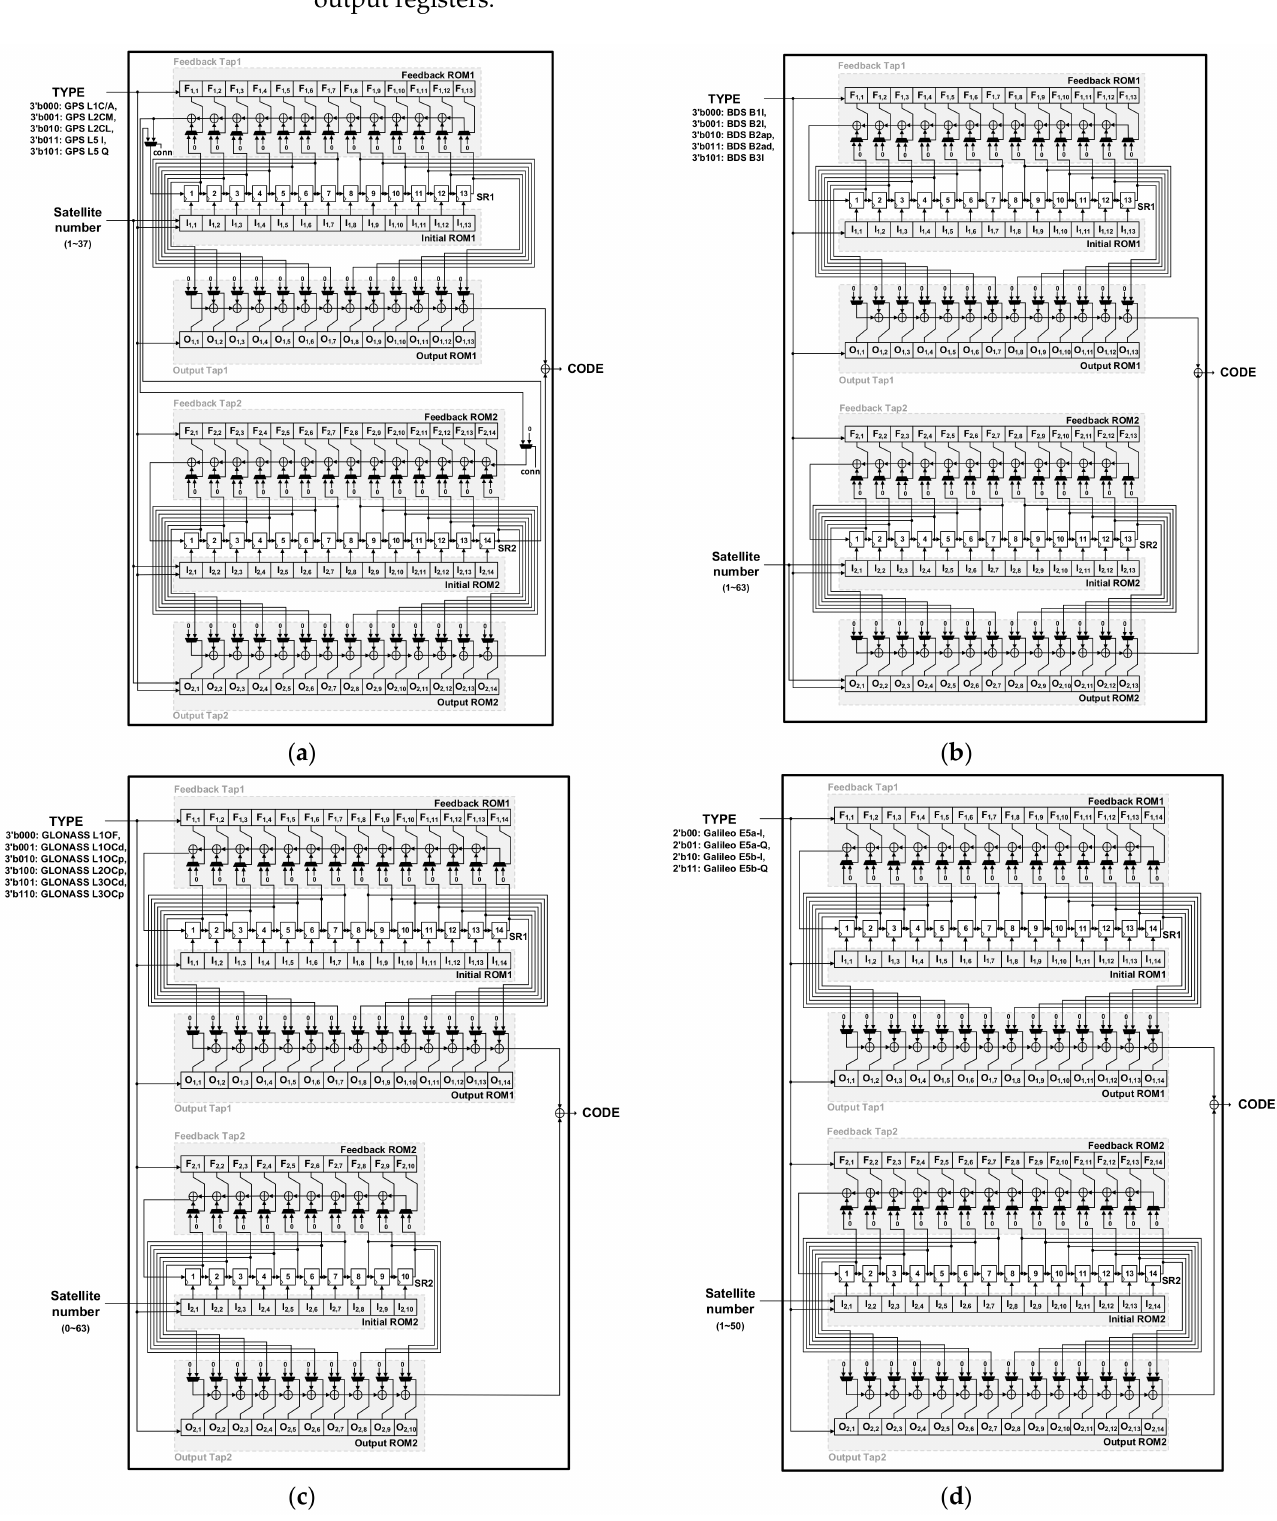
Figure 4. Previous multi-frequency universal code generator architectures [6] of each GNSS signal. ( a ) GPS. ( b ) BDS. ( c ) GLONASS. ( d )